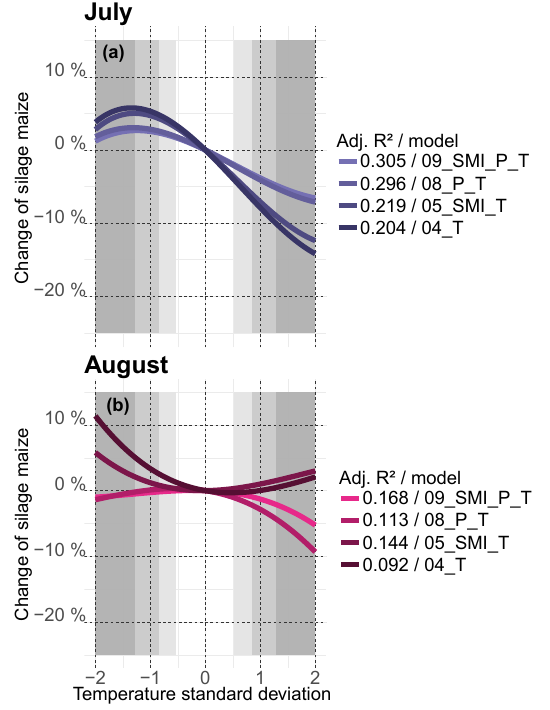
Figure 4. Sensitivity of the functional form of temperature partial effects for various controls for water